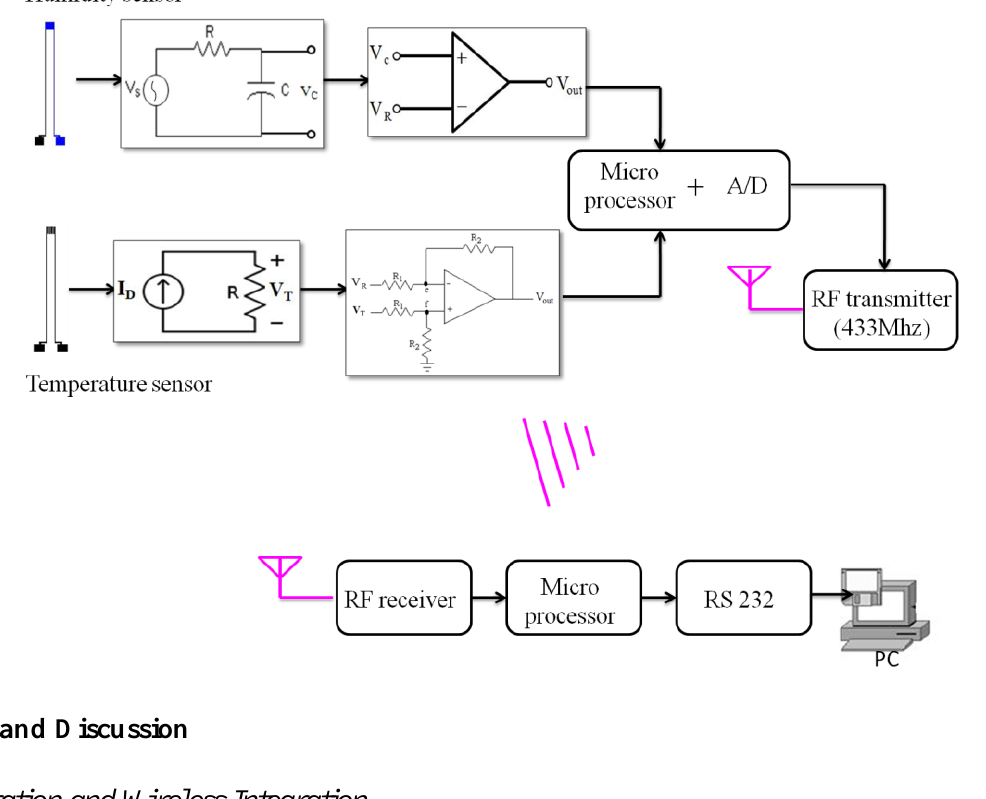
Figure 3. Block diagram of the wireless sensing